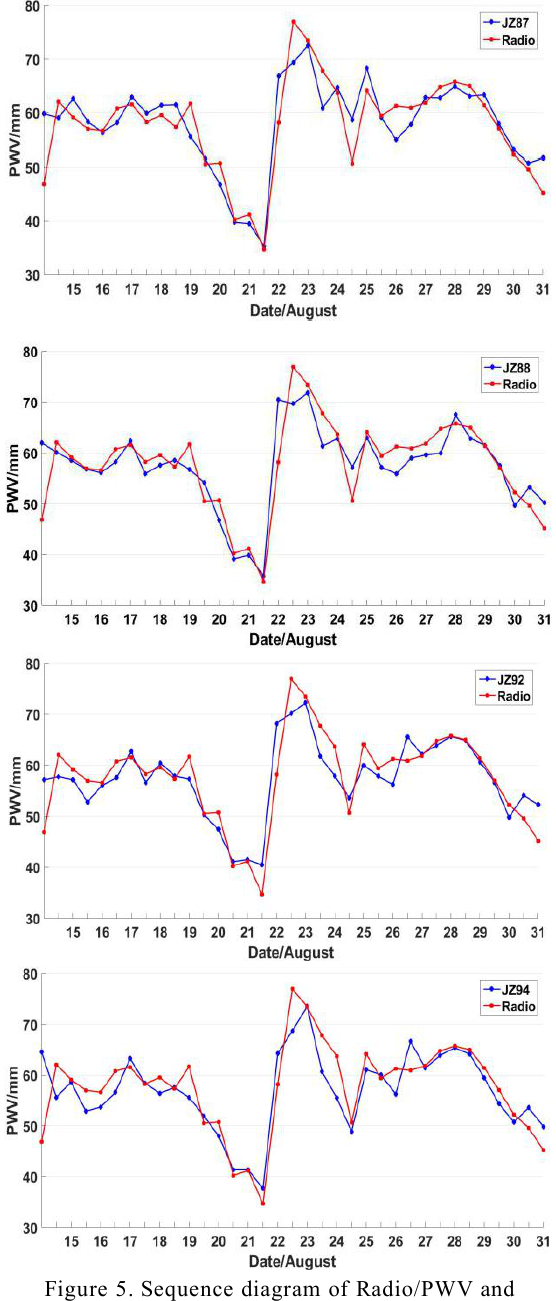
Figure 5. Sequence diagram of Radio/PWV and CORS/PWV